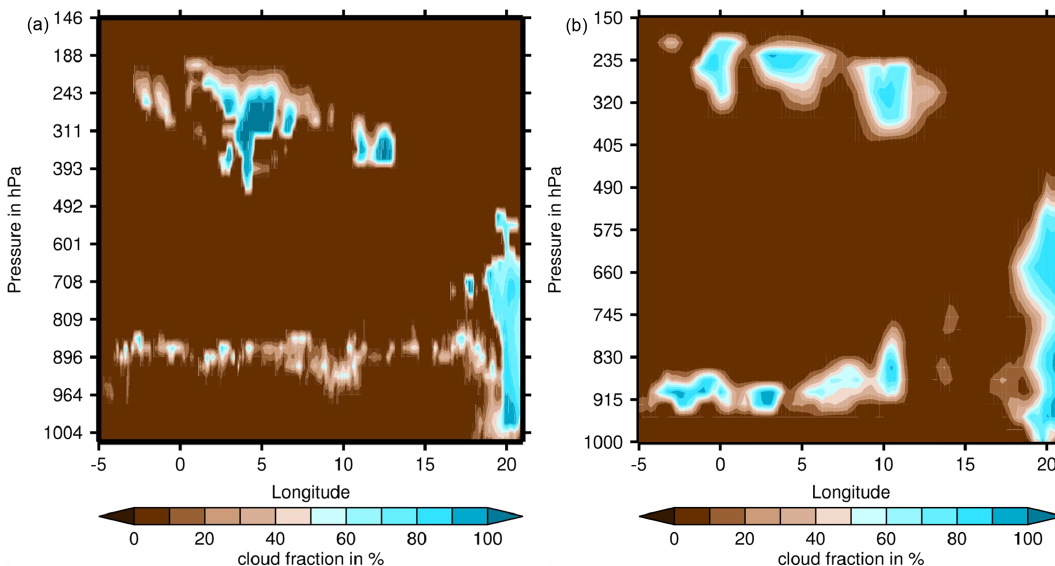
Figure 4. The cloudiness in the same situation: (a) ICON-EU and (b) ERA5.